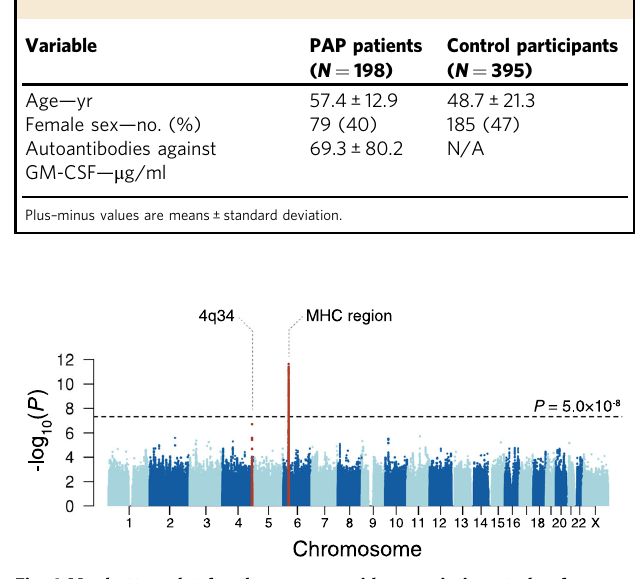
Fig. 1 Manhattan plot for the genome-wide association study of autoimmune pulmonary alveolar proteinosis. A Manhattan plot showing − log P ) of the genome-wide single-marker association test of aPAP in the 10 ( Japanese population. The dotted horizontal line represents a genome-wide signi fi cance threshold of P = 5.0 × 10 – 8 . The loci that satis fi ed the genome- wide signi fi cance threshold are colored in red. MHC, major histocompatibility